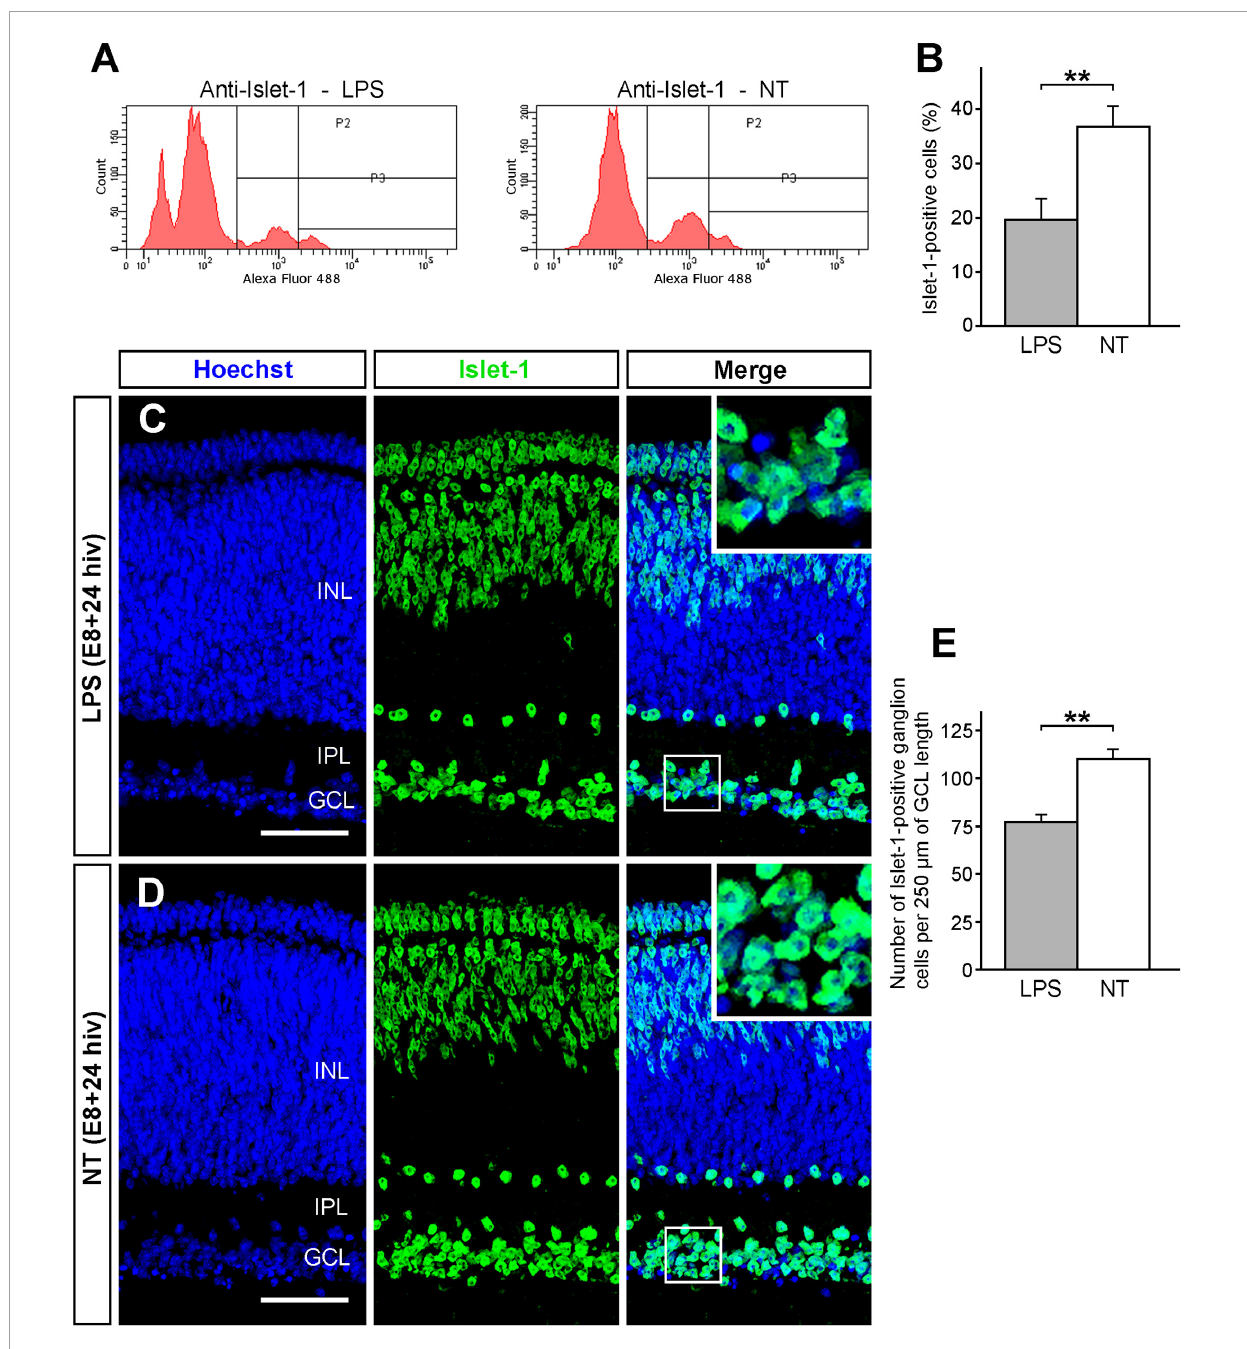
FIGURE3 Decrease of the ganglion cell population after LPS treatment. The Islet 1-positive ganglion cell population significantly declines after LPS treatment in retina explants from E8 quail embryos cultured for 24 h in vitro (E8 + 24 hiv). (A) Representative histograms showing flow cytometry analysis of cell suspensions from LPS-treated (LPS) and non-treated (NT) E8 + 24 hiv retina explants immunolabeled with the anti-Islet 1 antibody and revealed with Alexa Fluor-488-conjugated anti-mouse IgG. In the two histograms, P2 and P3 represent the Islet 1-positive cell population that is distinctly lower in LPS-treated than non-treated explants. (B) Percentages (means ± SEM) of Islet 1-positive cells obtained in the flow cytometry analysis of cell suspensions from LPS-treated (LPS, grey bar) and non-treated (NT, white bar) retina explants ( n = 8 for each condition). The Islet 1-positive cell percentage is significantly lower in LPS-treated versus non-treated explants (** P < 0.01, Student’s t-test). (C,D) Representative confocal images of anti-Islet 1 (green) immunolabeled cross-sections from LPS-treated [LPS; (C) ] and non-treated [NT; (D) ] E8 + 24 hiv retina explants. Nuclear stain with Hoechst 33342 (blue) was used to visualize the retinal layers (INL: inner nuclear layer; IPL: inner plexiform layer; GCL: ganglion cell layer). Blue, green and merged channels are shown in the left (Hoechst), medium (Islet 1) and right (Merge) panels, respectively. Insets in the right panels show higher magnifications of the boxed areas. The Islet 1-positive ganglion cells appear to be less numerous in LPS-treated explants (C) compared to non-treated ones (D) . Scale bars: 45 µ m. (E) Quantification of Islet 1-positive cells in the GCL of LPS-treated (LPS, grey bar) and non-treated (NT, white bar) E8 + 24 hiv retina explants. The quantitative analysis was performed on three cross sections from dorsal, medial, and ventral parts of LPS-treated and non-treated explants ( n = 8 for each condition). Data are expressed as means ( ± SEM) of numbers of Islet 1-positive cells per 250 µ m of GCL length in each histological section. The number of Islet 1-positive ganglion cells is significantly lower in LPS-treated than in non-treated explants (** P < 0.01, Student’s